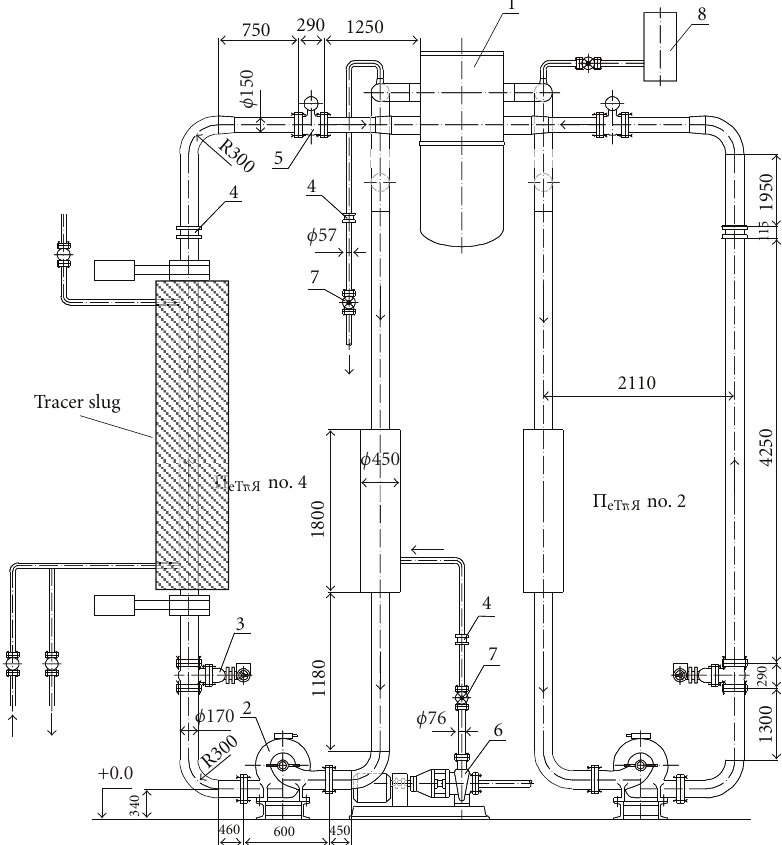
Figure 2: Location of the tracer